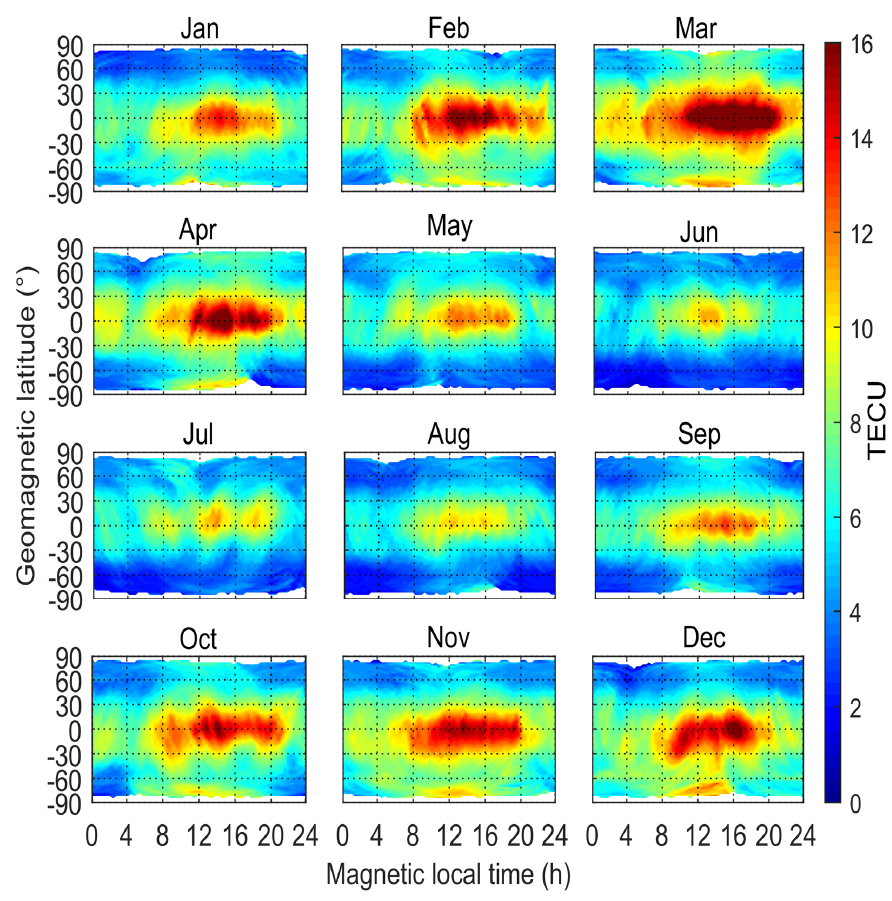
Figure 8. Monthly variation of plasmaspheric TEC in 2014.